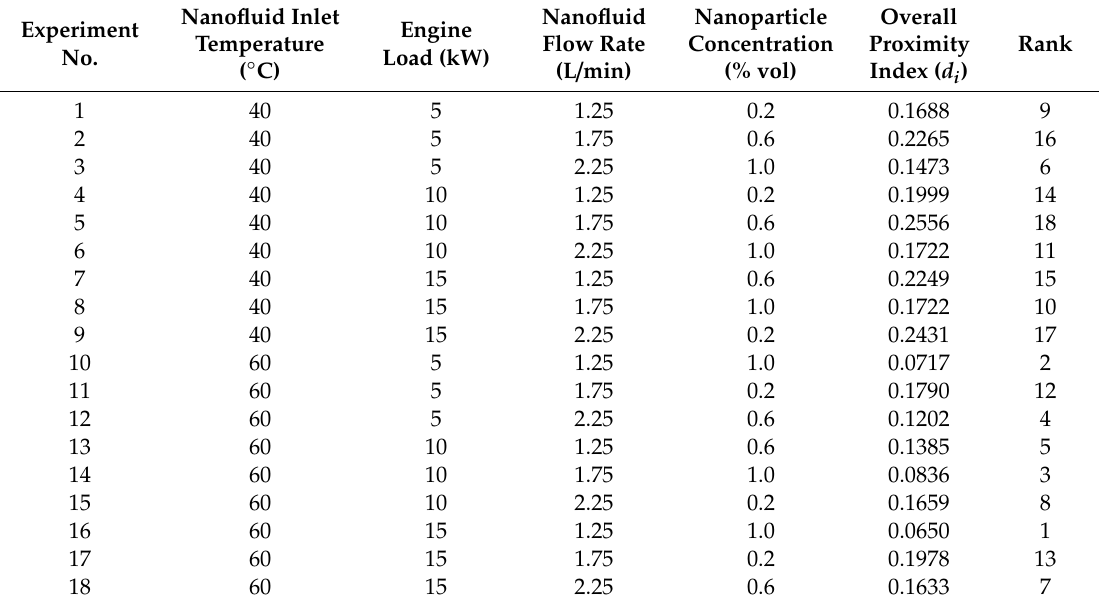
Table 9. Overall proximity index ( d i